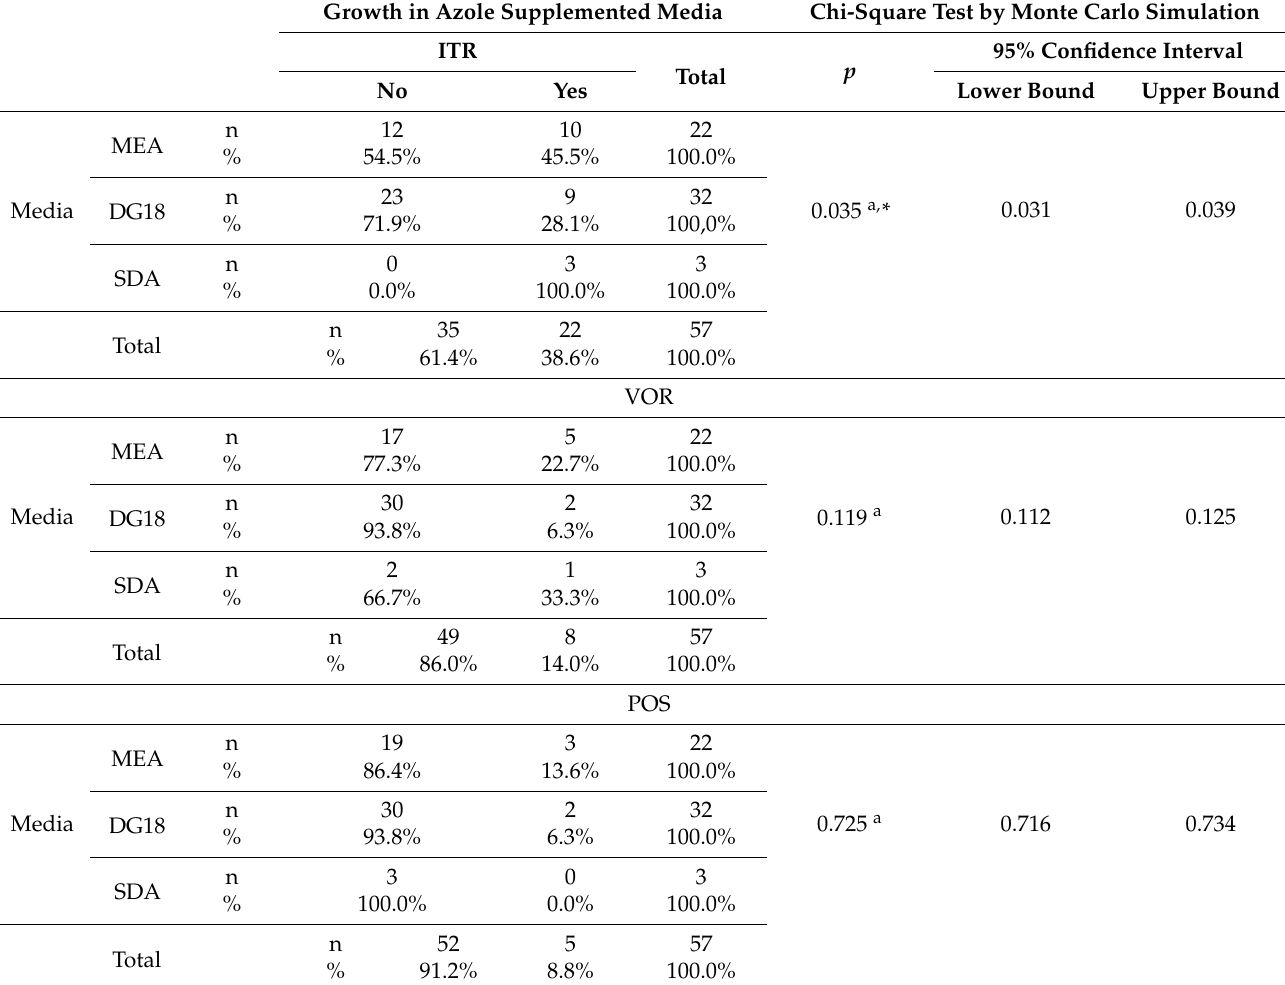
Table 7. Relation between Aspergillus section Fumigati isolates on azole-supplemented SDA (ITR, VOR, and POS) and first isolation media (MEA, DG18, and SDA). Results of the Chi-Square test by Monte Carlo simulation. Growth in Azole Supplemented